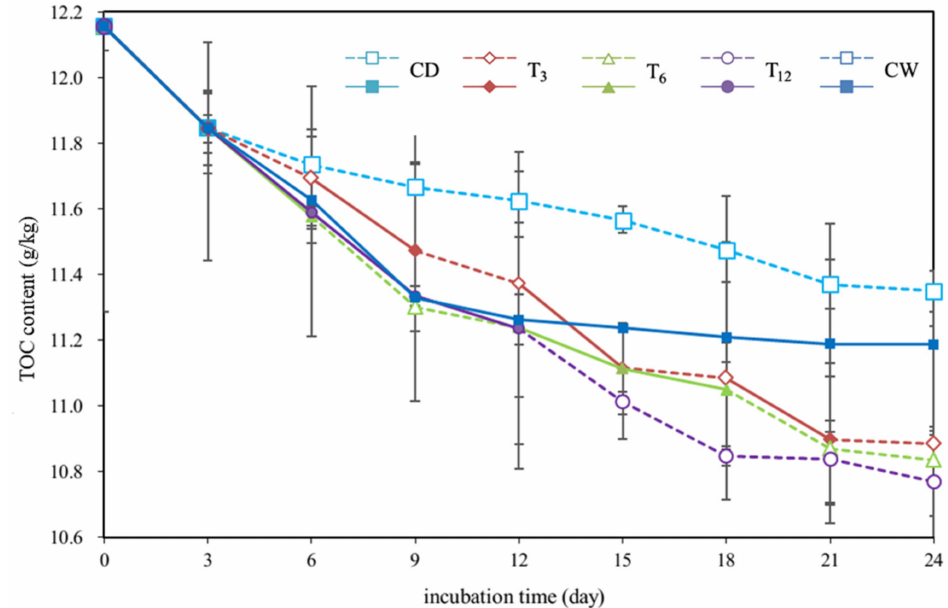
Figure 7. The dynamic of TOC content in different treatments. The solid and dotted lines represent the rewetting and drying period, respectively. The vertical bars refer to one standard deviation ( n = 3).